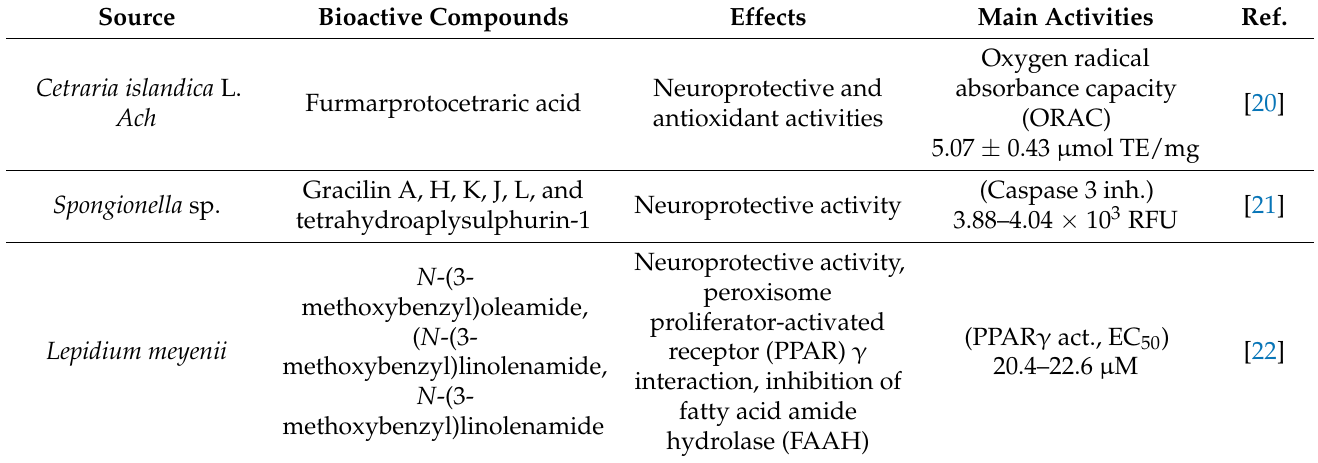
Table 1. Natural compounds and neurodegenerative